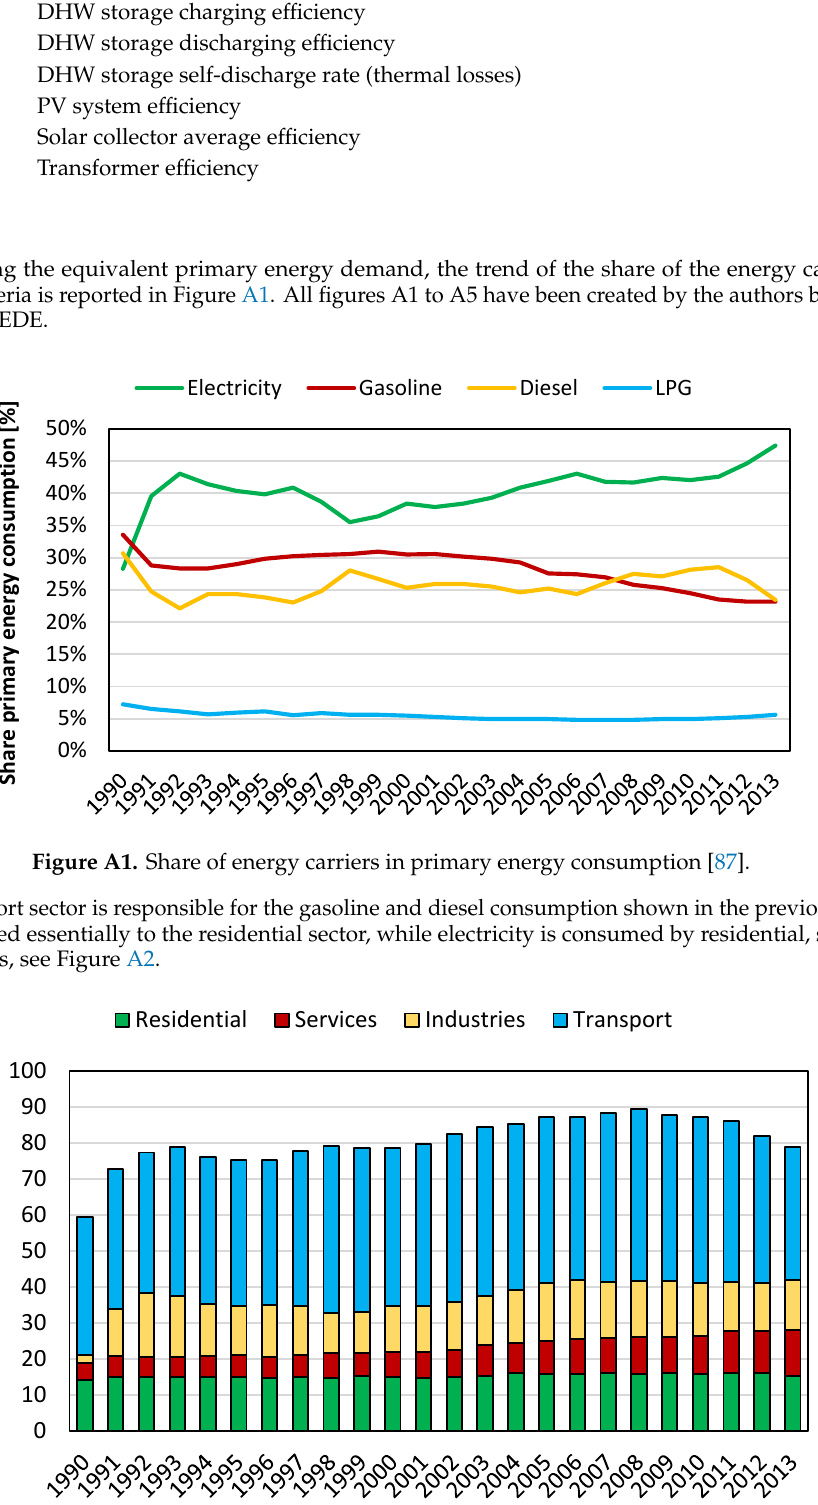
Figure A2. Primary energy consumption by sector in Pantelleria [87].